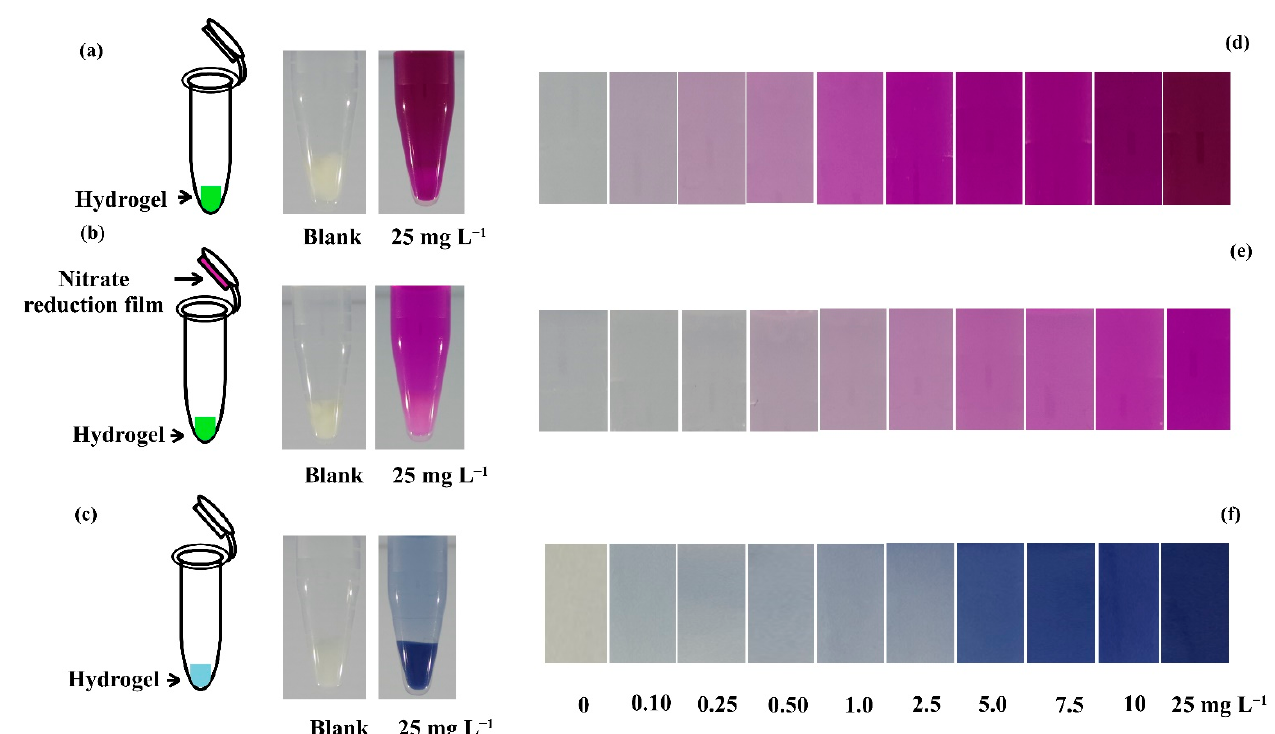
Figure 1. In-tube hydrogel test kits for ( a ) nitrite, ( b ) nitrate, and ( c ) phosphate detection and the colorimetric products obtained from the testing of standard solutions with the ( d ) nitrite, ( e ) nitrate, and ( f ) phosphate test kits.